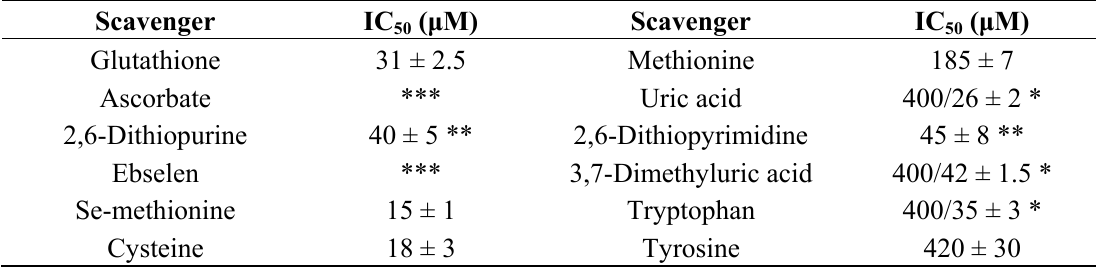
Table 3. Half-maximal inhibition concentrations (IC the inactivation of alcohol dehydrogenase (26 nM) by peroxynitrite (20 μ